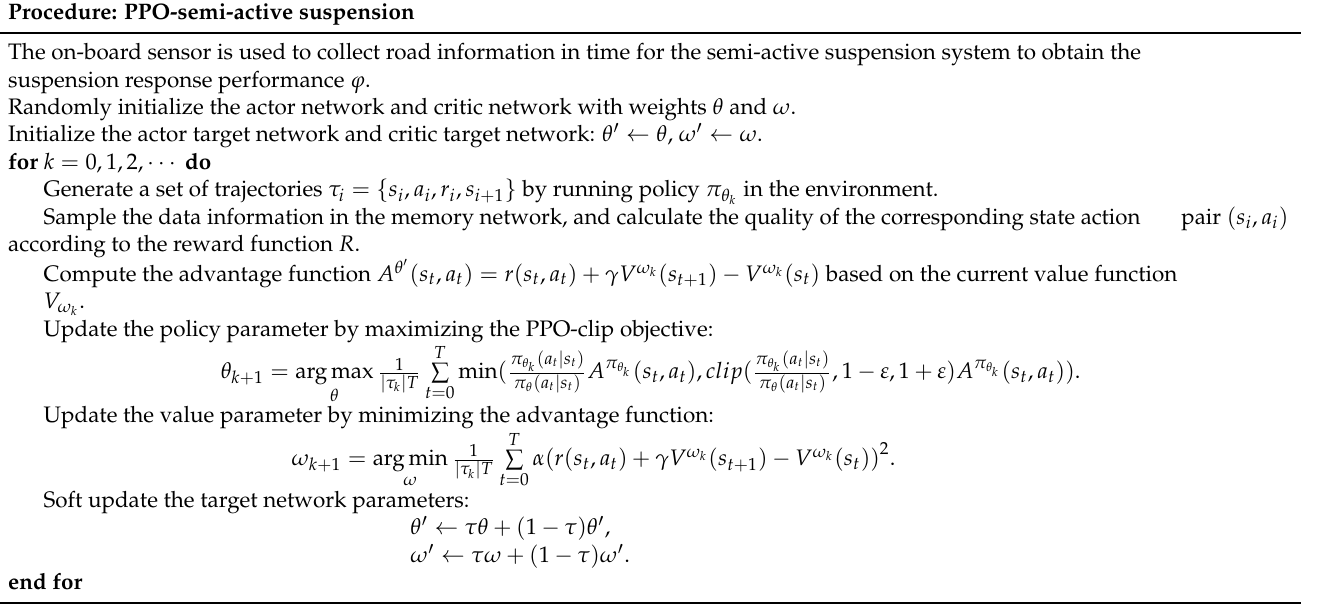
Table 2. Proximal policy optimization algorithm-semi-active suspension.